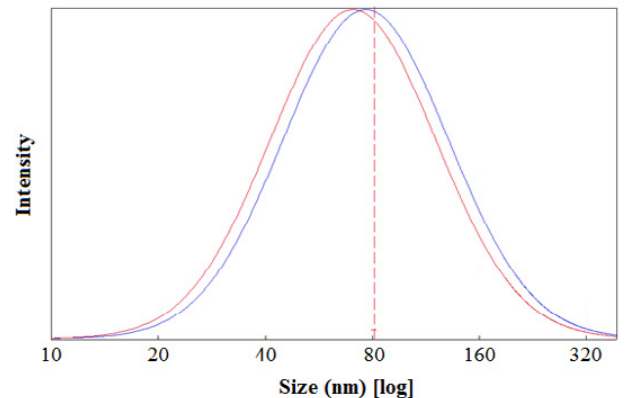
Fig. 7. PCS histogram of sample A1.